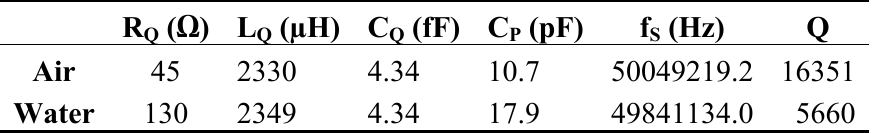
Table 1. Experimental values of the BVD equivalent circuit for the quartz in air and immersed in distilled water.